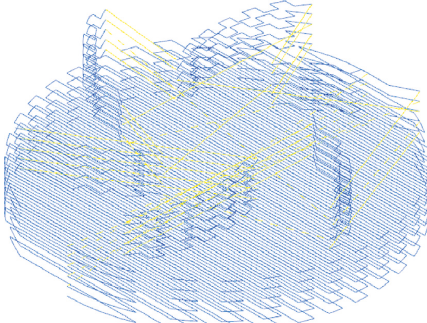
Figure 17: Toolpaths for the deposition of the impeller with re- usable substrate